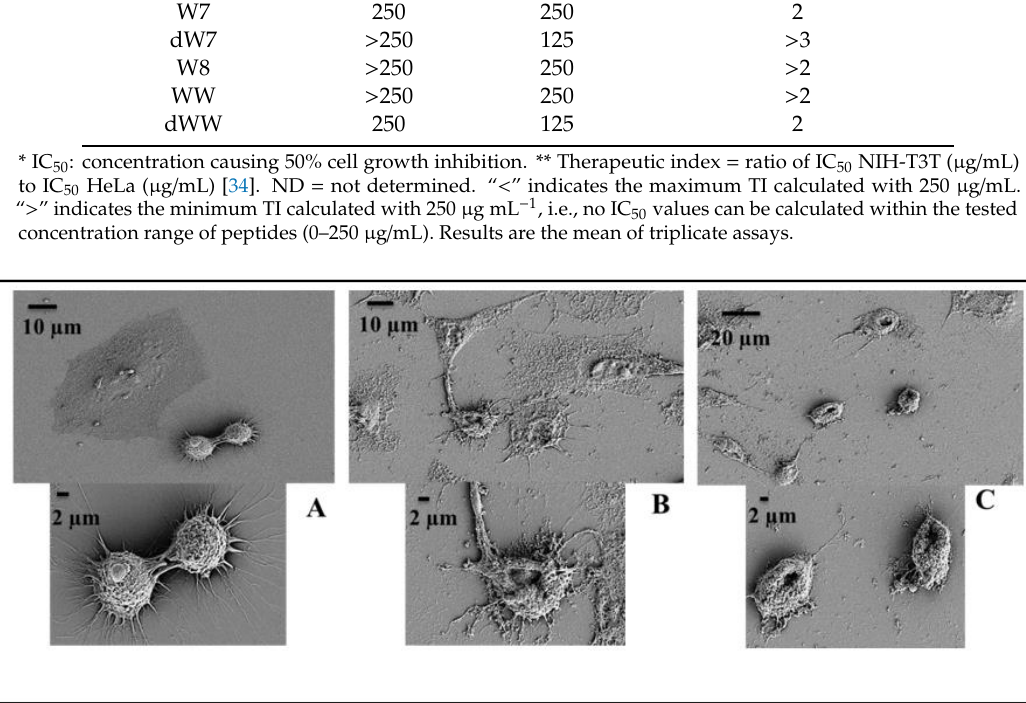
Figure 5. Scanning electron micrographs of HeLa cells after treatment with P1 and Di-PuroA peptides. ( A ): no-peptide control; ( B ): P1 (32 µg/mL); ( C ): Di-PuroA 64 µg/mL.